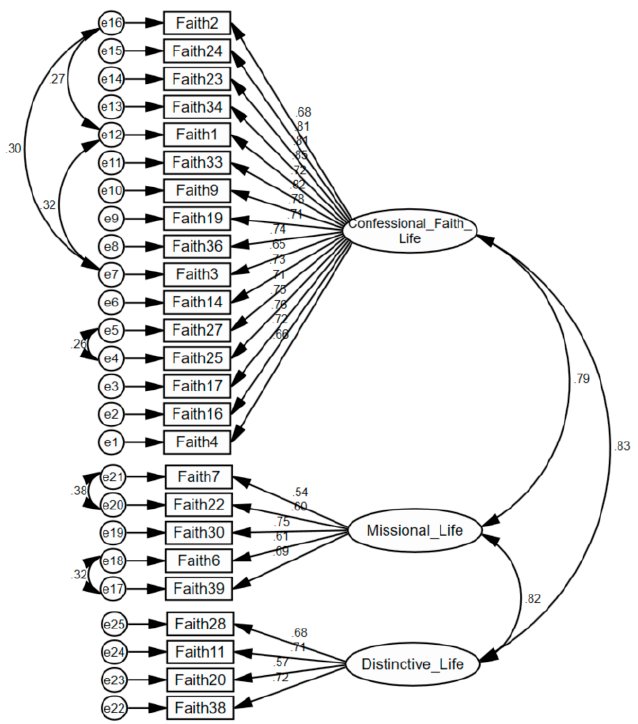
Figure 1. The path diagram of model.